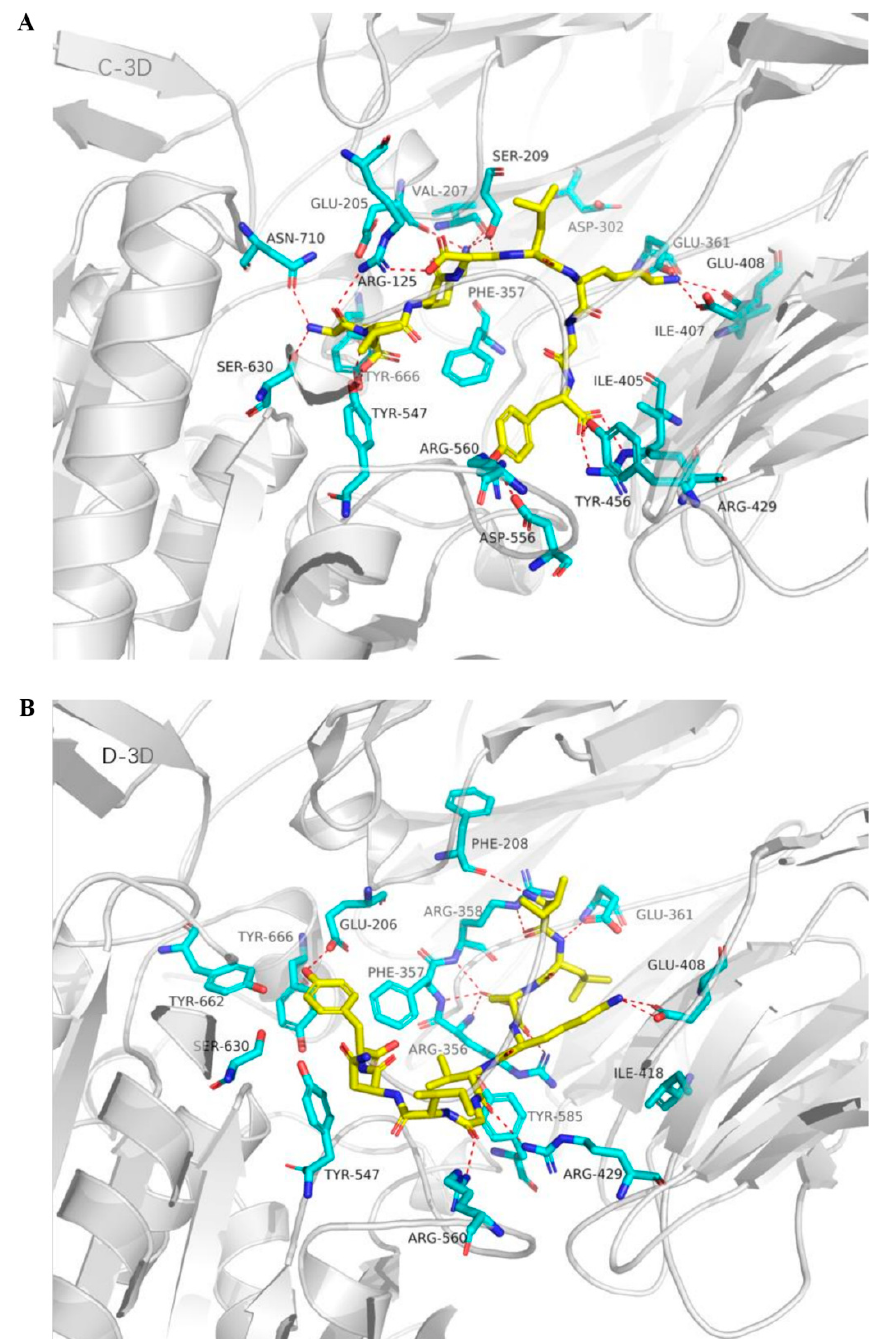
Figure 7. Details of ELKDLKGY ( A ) and ILDKVGINY ( B ) interaction at the DPP-IV interaction sites. Peptide ligands are colored in yellow, and the surrounding residues in the binding pockets are colored in cyan. The backbone of the receptor is depicted as light gray ribbon. The red dot line shows the hydrogen bond between ligand and receptor.